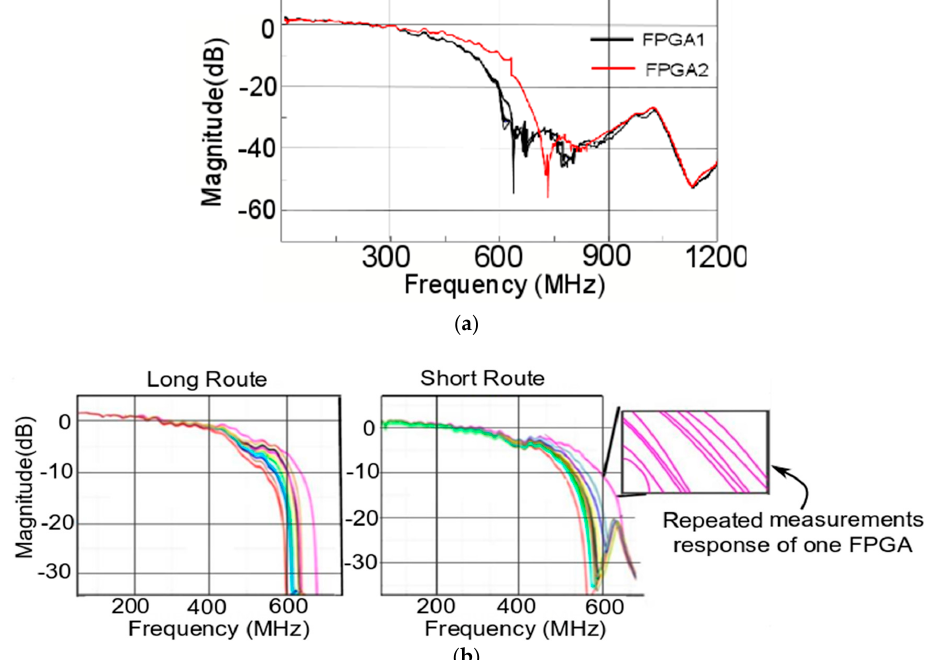
Figure 7. S21 response. ( a ) S21 response for full bandwidth measurement. ( b ) S21 response from the 11 FPGAs for two different routes, with each measurement done 10 times. Inset zoom on one of FPGA response to show the repeatability of measurement 10 times.